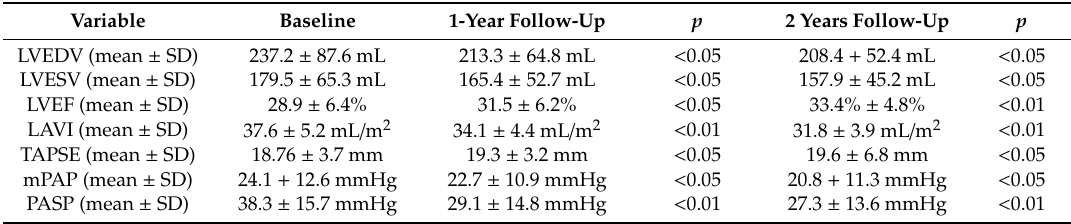
Figure 2. Improvement in the right ventricular arterial coupling during follow-up. TAPSE—tricuspid annular plane systolic excursion; PASP—pulmonary artery systolic pressure; ns—not significant.